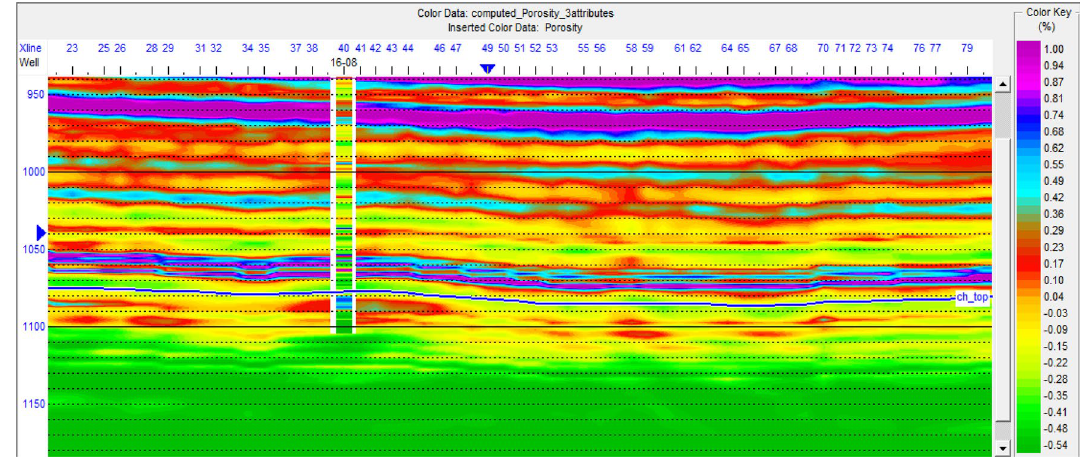
Fig. 18 Porosity obtained from applying multi-attribute regression on the third category data at one section, and the desired well parameter